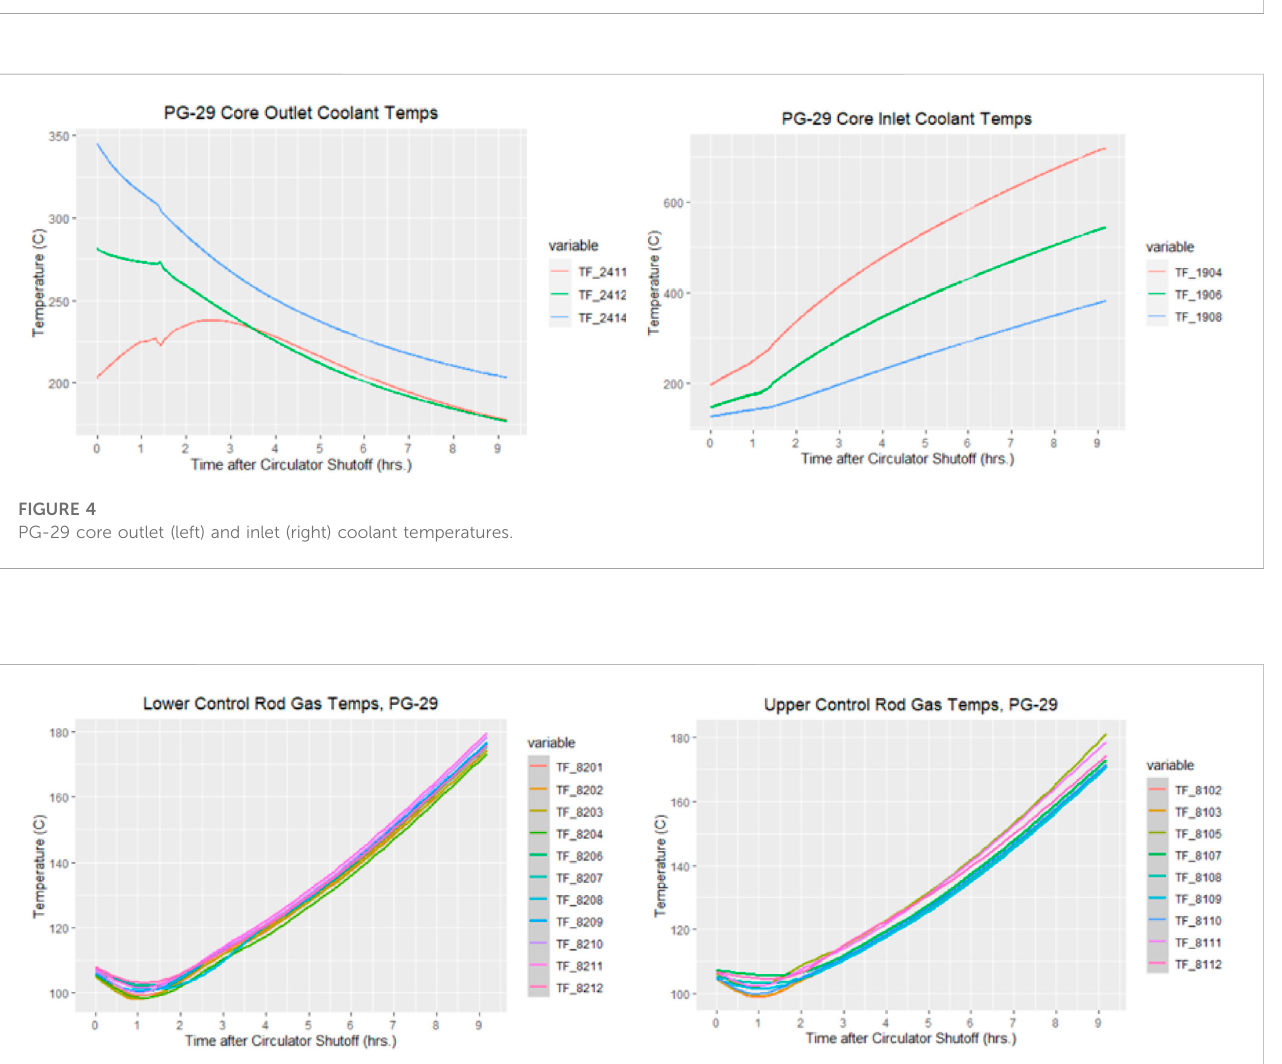
FIGURE 5 PG-29 upper plenum, lower (left) and upper (right) control rod gas temperatures.